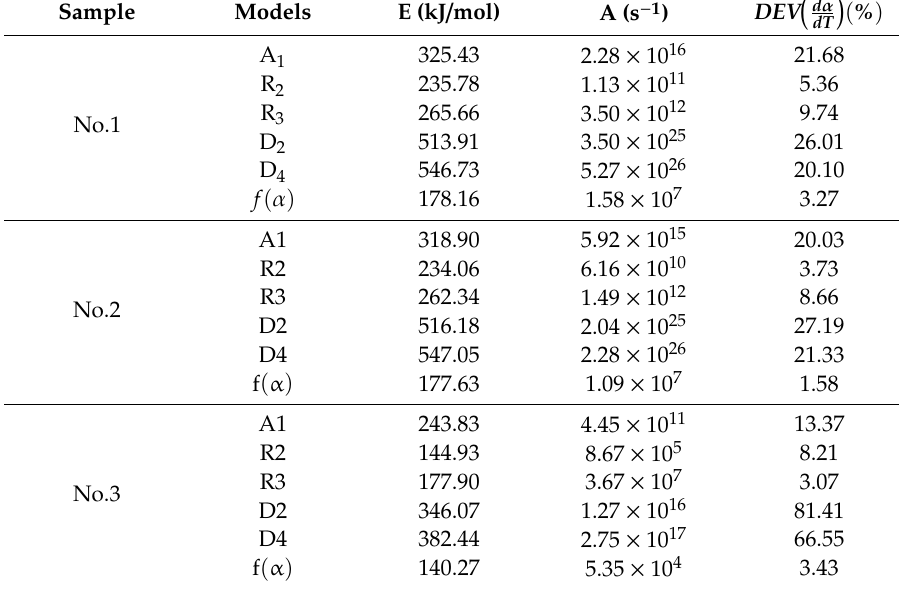
Table 1. Kinetic parameters and relative errors obtained from di ff erent models.